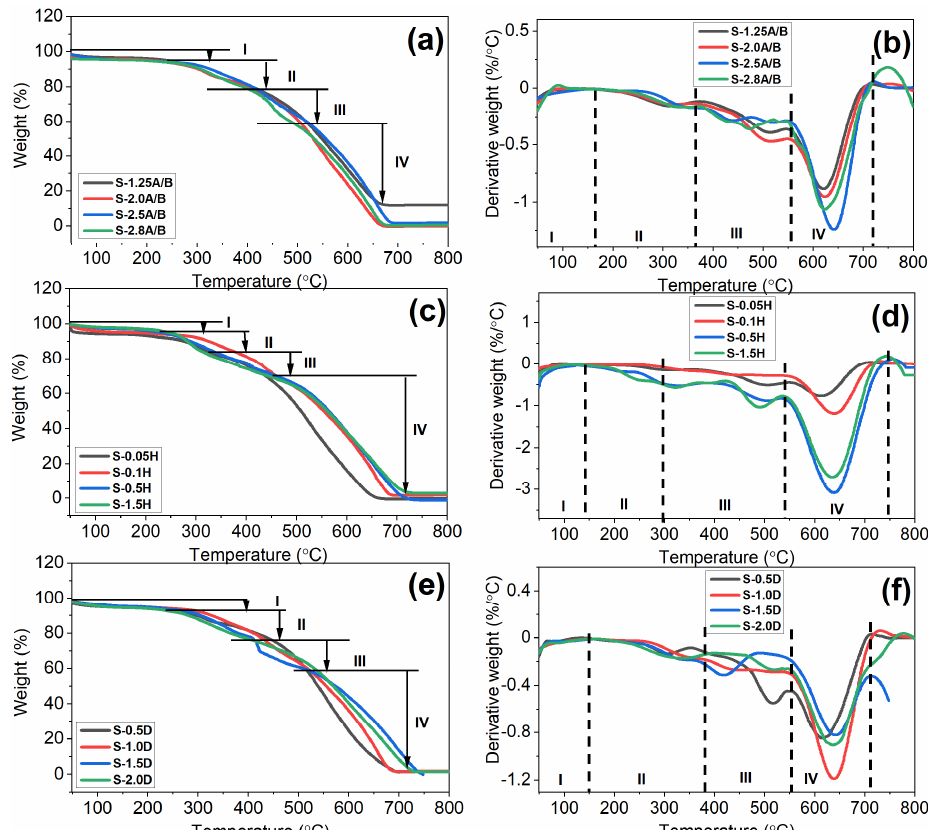
Figure 5. TGA and DTGA profiles of as ‐ synthesized Pbp materials at different ( a , b ) APS/BP mole ratio (1.25–2.8) through varying benzopyrrole concentration, ( c , d ) H 2 SO 4 concentration (0.05–1.5 M), and ( e , f ) DBSA concentration (0.5–2.0 mL).